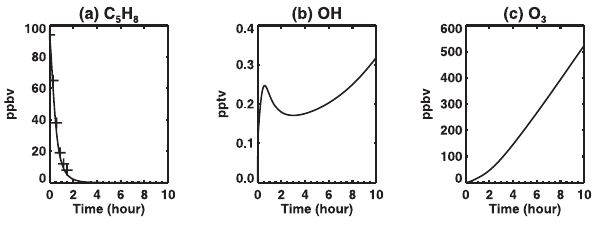
Fig. 3. Calculated mixing ratios of (a) isoprene, (b) OH and (c) ozone in the experiment of Paulot et al. (2009). The reported measurements of isoprene are shown as black